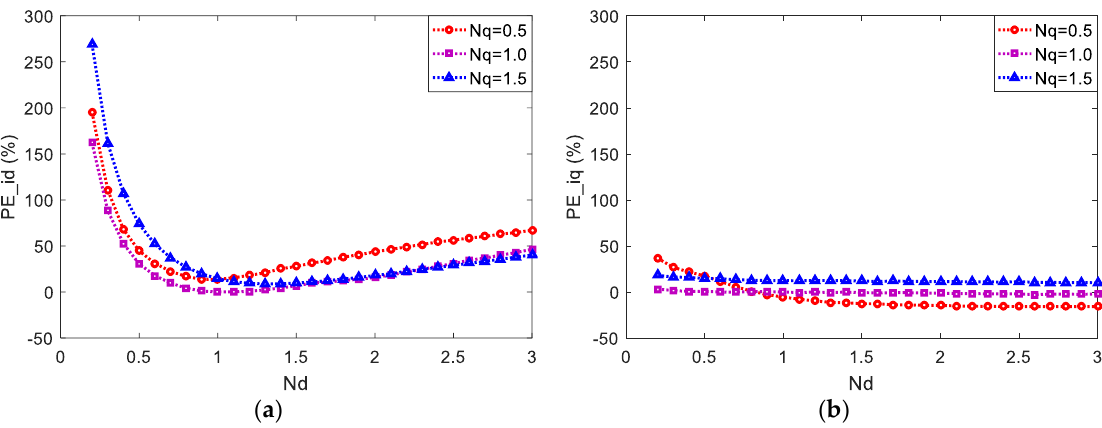
Figure 7. Relative prediction error under N d step changes for three N q settings. ( a ) Relative prediction error of i d ; ( b ) Relative prediction error of i q .